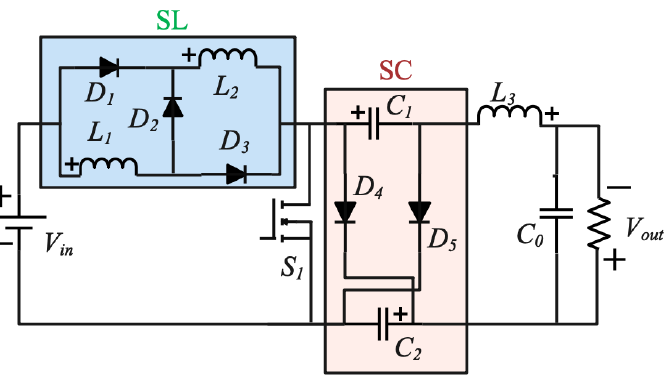
Figure 4. Topology 1: Power circuit of type-1 switched-inductor-switched-capacitor (SLSC) Cuk converter.